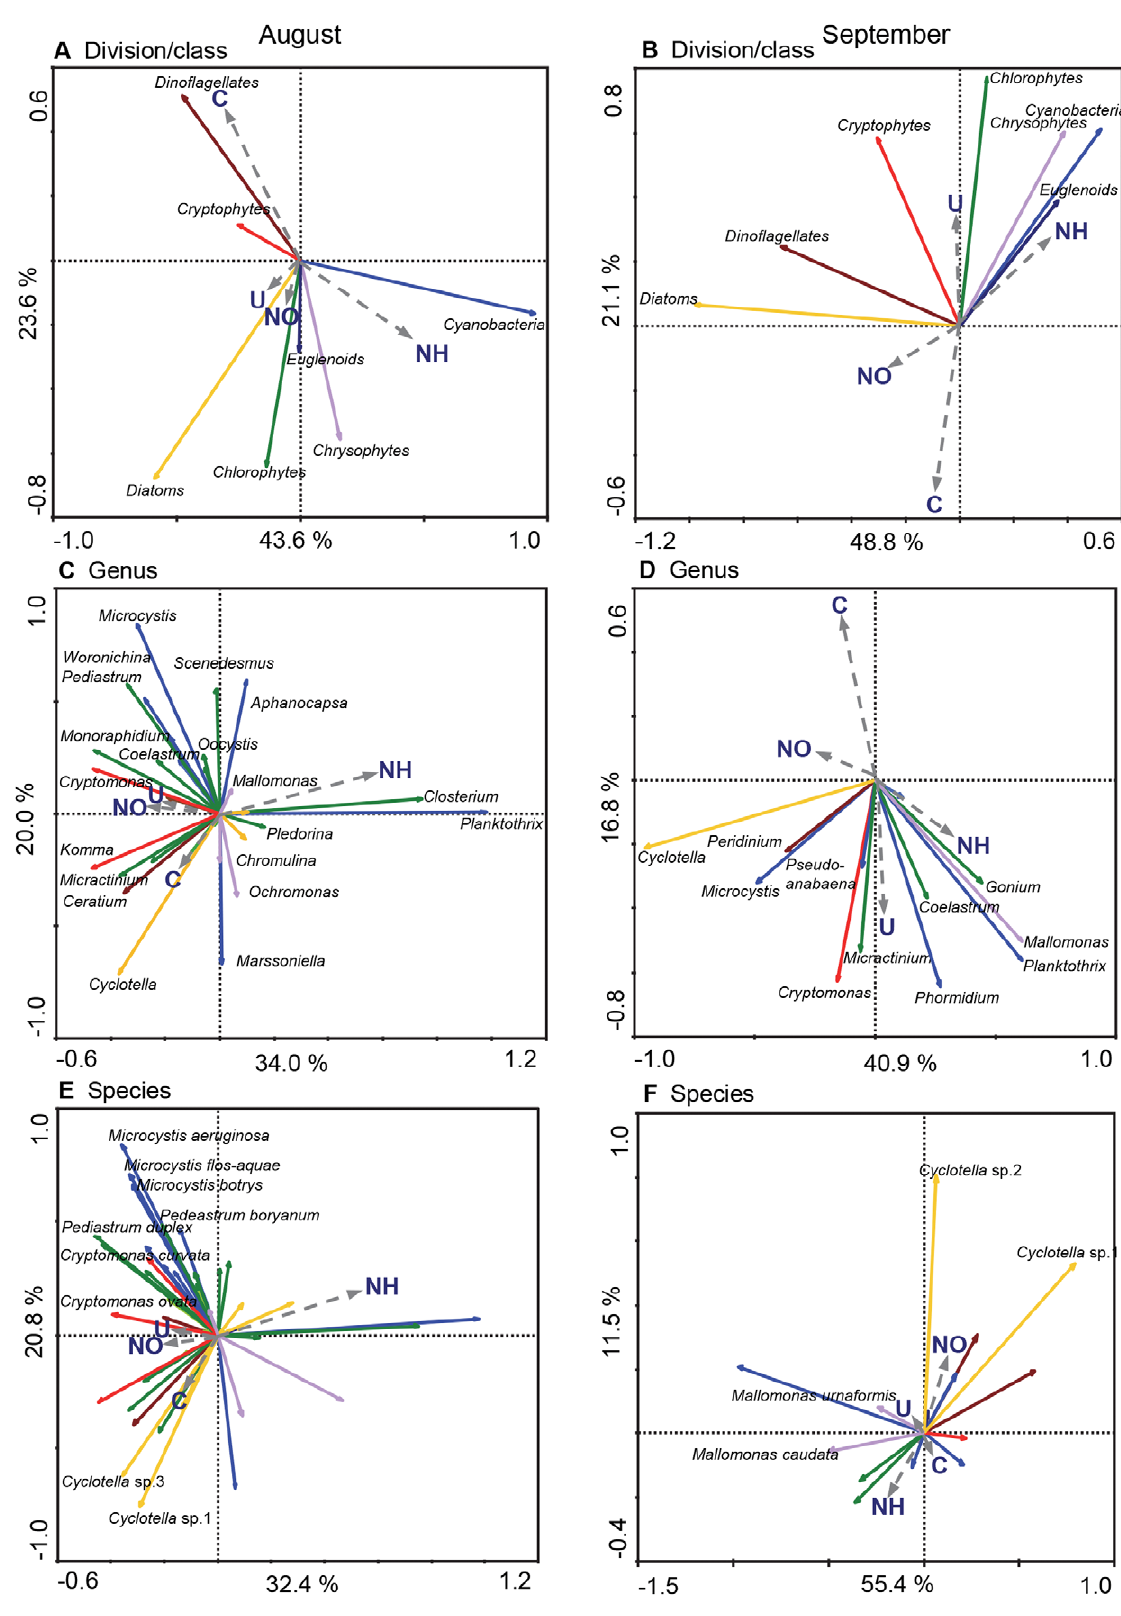
Figure 5. Principal component analysis of experimental phytoplankton assemblages at the a) division, b) genus, and c) species level of taxonomic resolution. Genera and species were selected if their cumulative biomass over the course of each experiment was more than 1% of the total for any of the 12 enclosures. Algal densities were log 10 (x + 1)-transformed as needed, and categorical nitrogen treatments (e.g., + or –